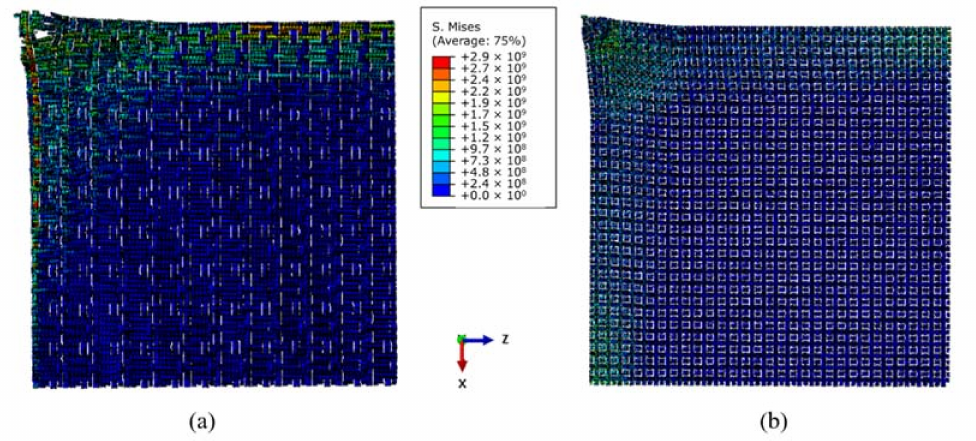
Figure 11. Range of back face stress distribution on 1/4 geometric model of ( a ) 5-AI and ( b )